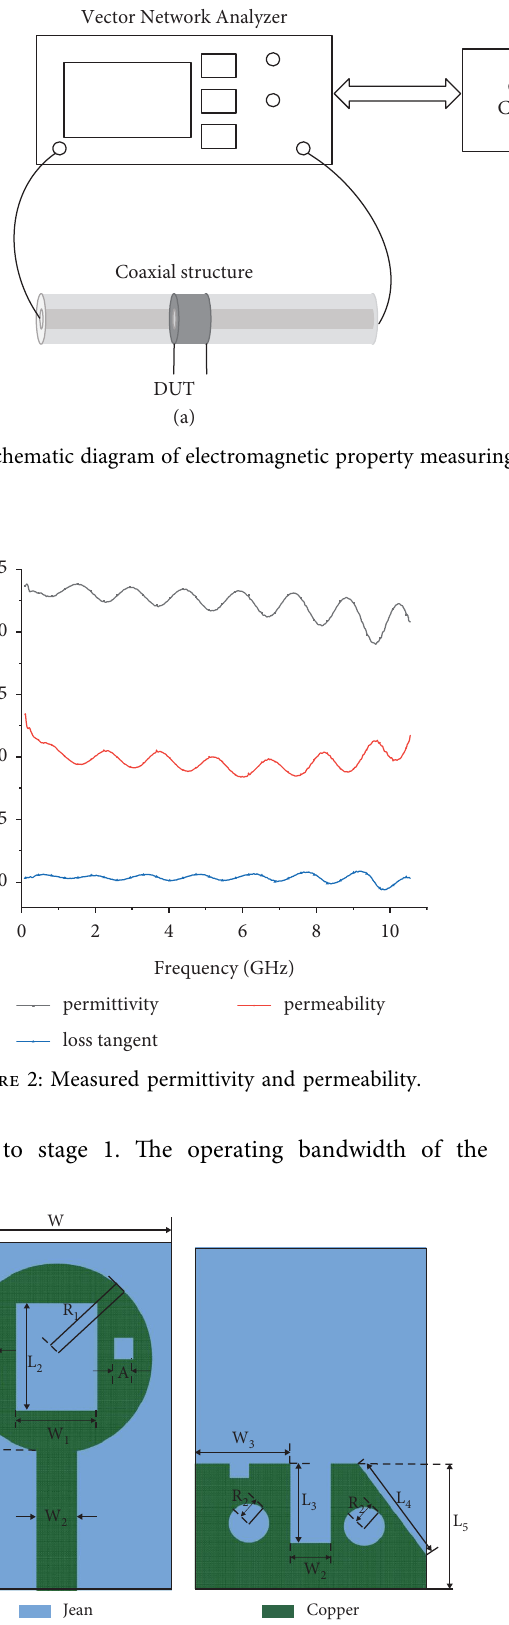
Figure 3: Geometry of the proposed antenna. (a) Front view. (b) Rear